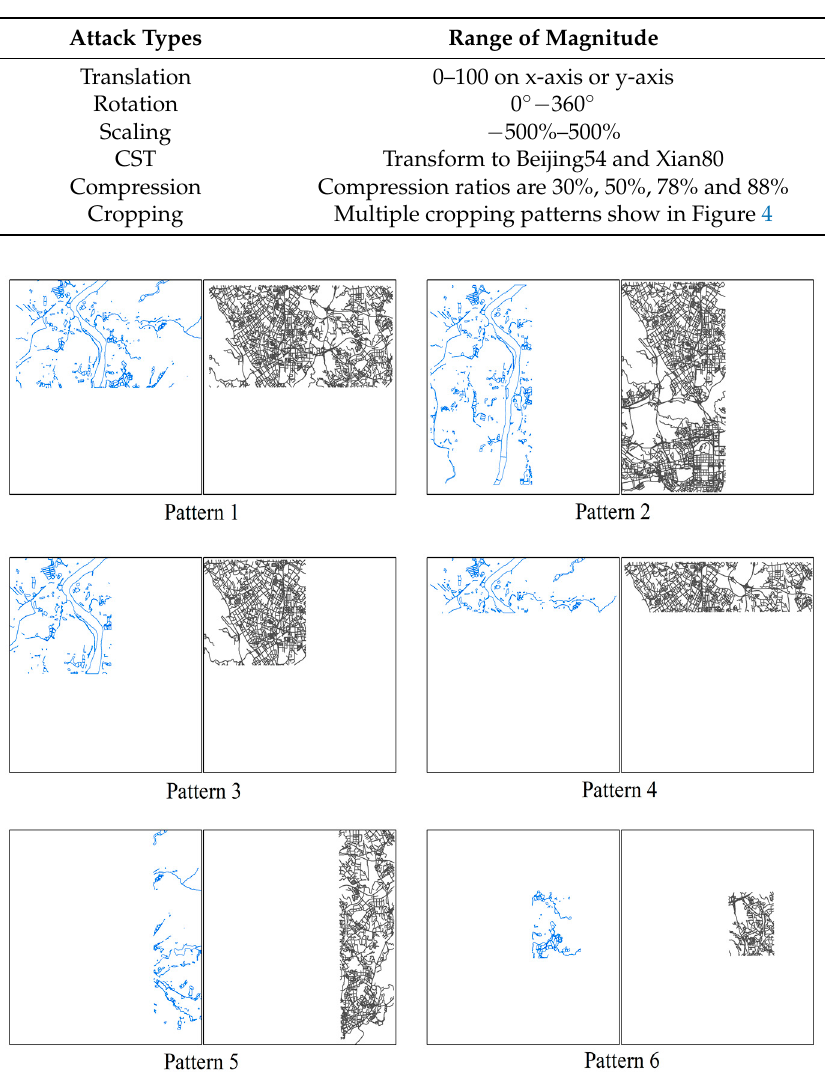
Figure 4. Different cropping patterns. Pattern 1 cropped the lower half of the original maps by approximately 1/2. Pattern 2 cropped the right half of the original maps by approximately 1/2. Pattern 3 left approximately 1/4 of the upper left corner of the original maps. Pattern 4 left approximately 1/4 of the first half of the original maps. Pattern 5 left approximately 1/4 of the right half of the original maps. Pattern 6 left approximately 1/8 of the upper right of the original maps.